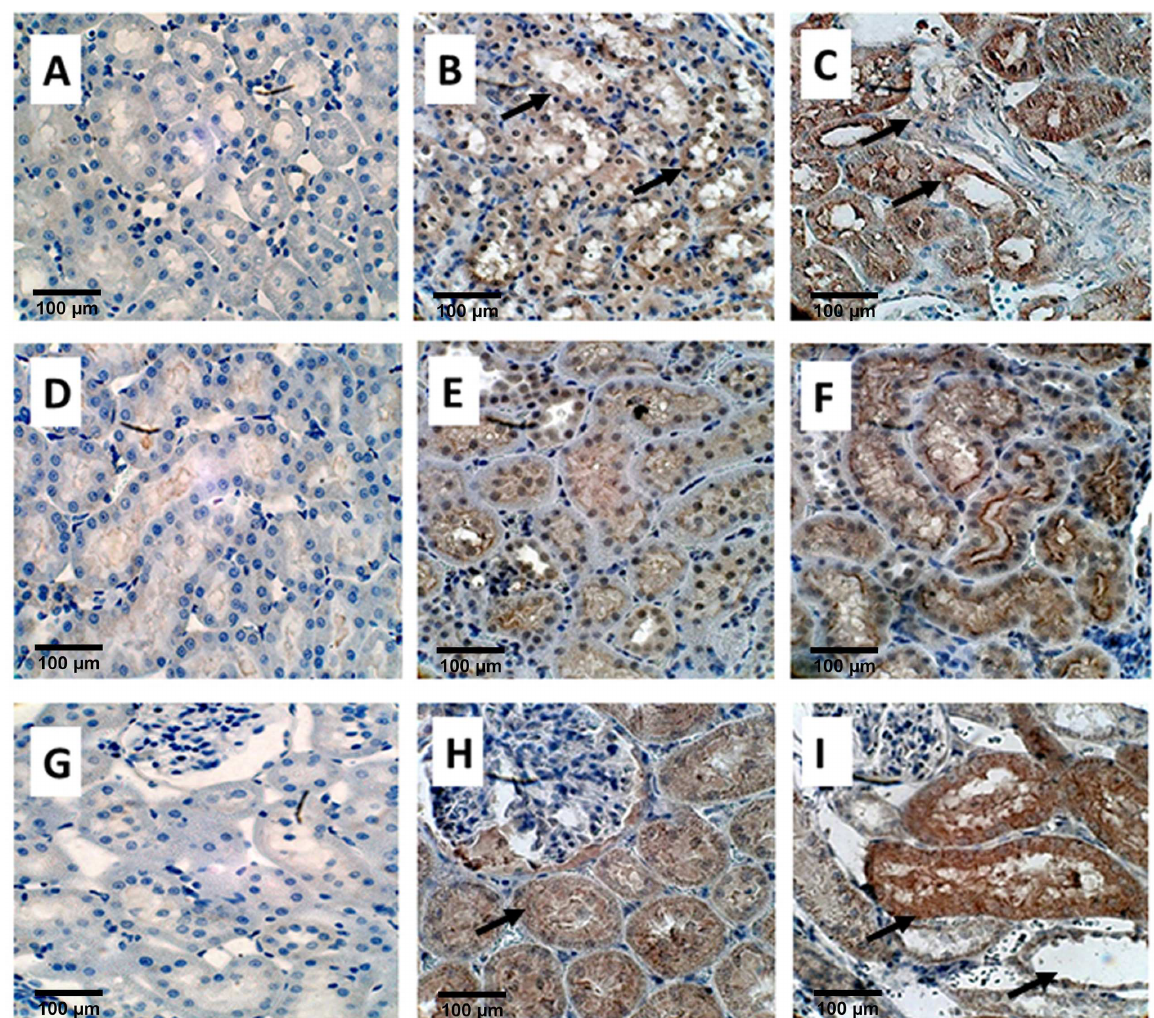
Fig 4. Immuno-histological staining of EG treated rat kidneys. OPN , A) ControlB) on Day 14 showinglight stainingof the tubular epithelialcells, shown by black arrows and C) on Day 28 showingstrong staining of renal tubular epithelialcells as well as tubular contents (Black arrows), Magnification, X 40, Scale bar 100 μ m, MGP, D) ControlE) light staining on Day 14 and F) heavy stainingon D28 Magnification, X 40, Scale bar 100 μ m. Fetuin B , G) Control, H) Non-specific diffuse staining of epithelialcells on Day 14, shown by a singleblack arrow, and I) Heavy stainingof cells as well as luminalcontents (top black arrow), particularly those with crystals which have droppedout duringprocessingshown by bottom right black arrow.